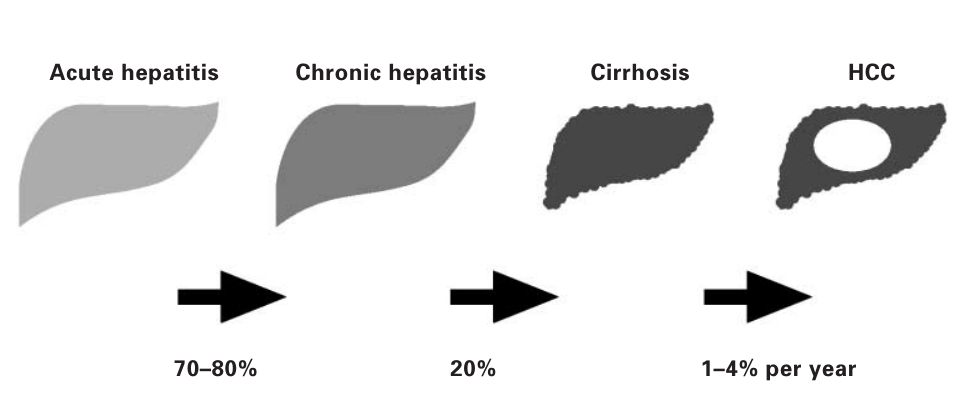
HCV life cycle. (1) Virus binding and in- ternalization, (2) cyto- plasmic release and uncoating, (3) IRES- mediated translation, (4) polyprotein pro- cessing, (5) RNA replication, (6) pack- aging and assembly, (7) virion maturation, (8) virion